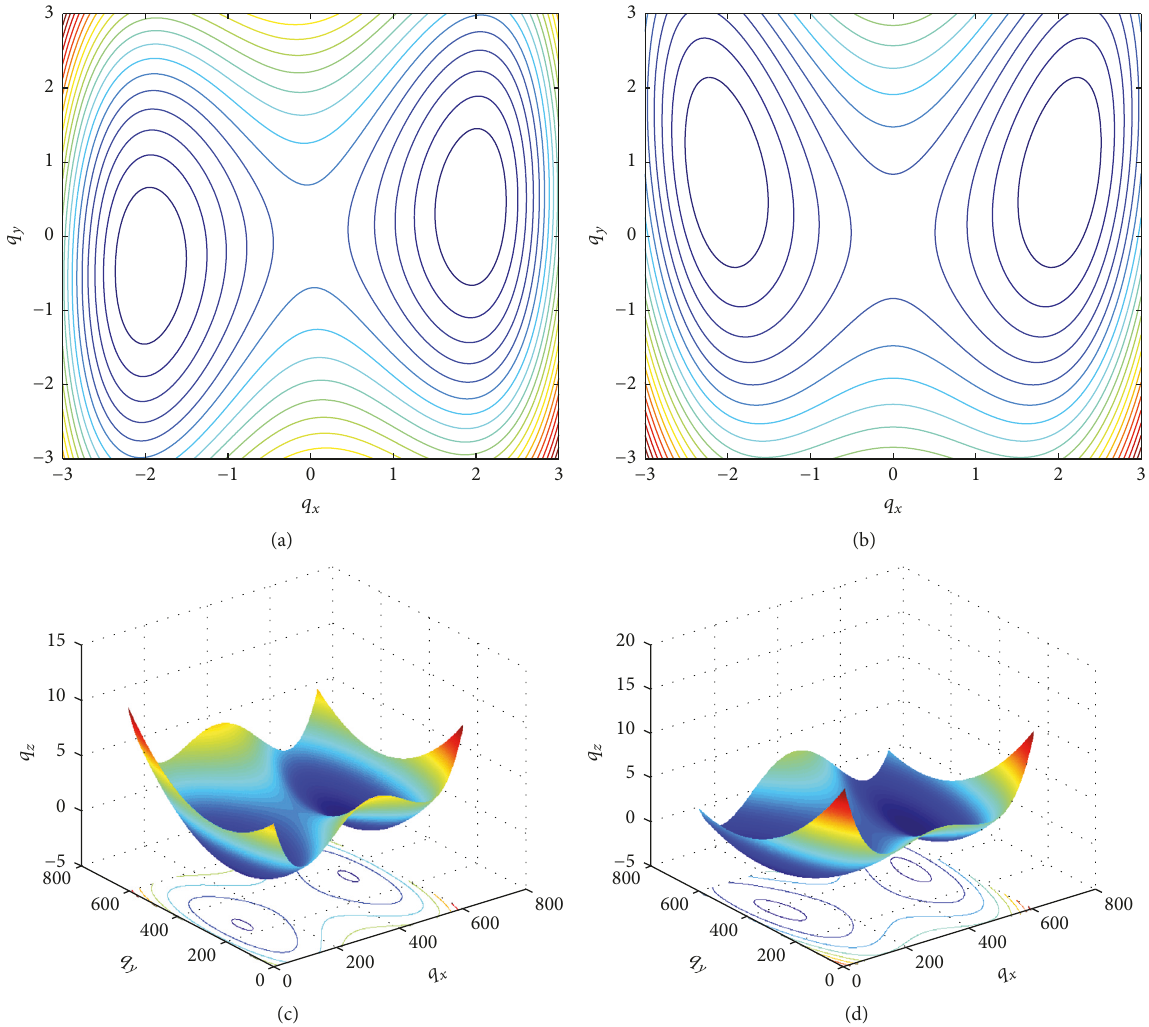
Figure 1: The contour plots ((a) and (b)) and the mesh plots ((c) and (d)) of the potential with linear and quadratic coupling. The parameters are fixed: 𝛼 = 0.2 , 𝜅 = 3 , 𝛾 = 0.5 , and 𝜎 = 0.3